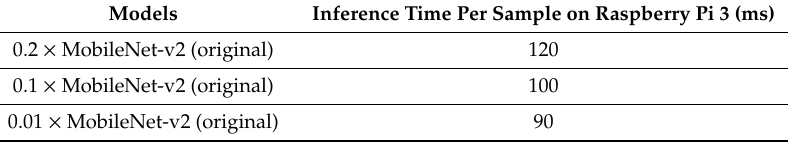
Table 7. Inference time on Raspberry Pi 3 of convolutional neural networks (CNN) at various scaling rates.